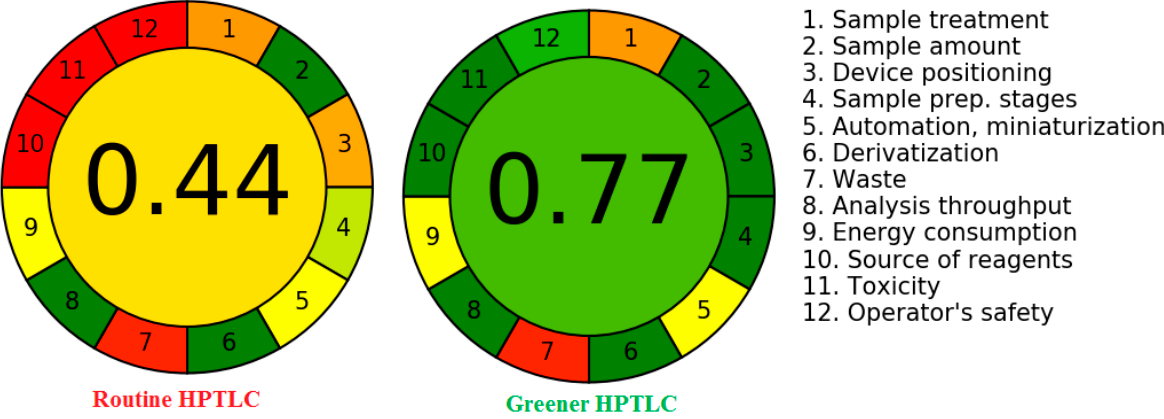
Figure 5. Representative diagrams for AGREE indices for the routine and greener analytical methods estimated utilizing “AGREE: The Analytical GREENness Calculator”.